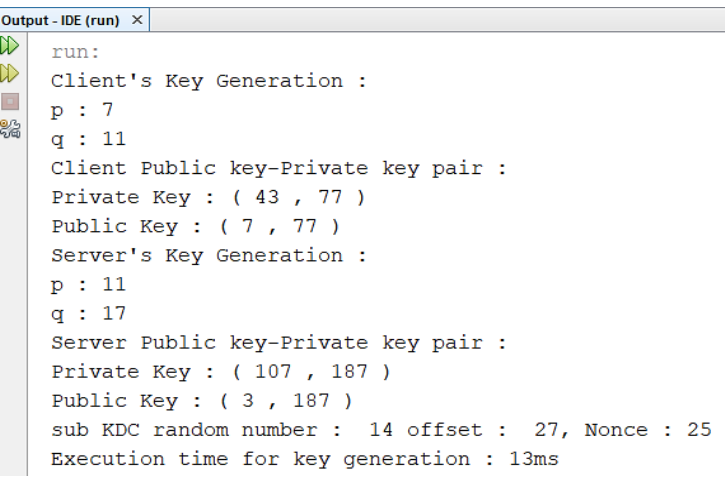
Figure 5. Client and Server’s Public – Private Key